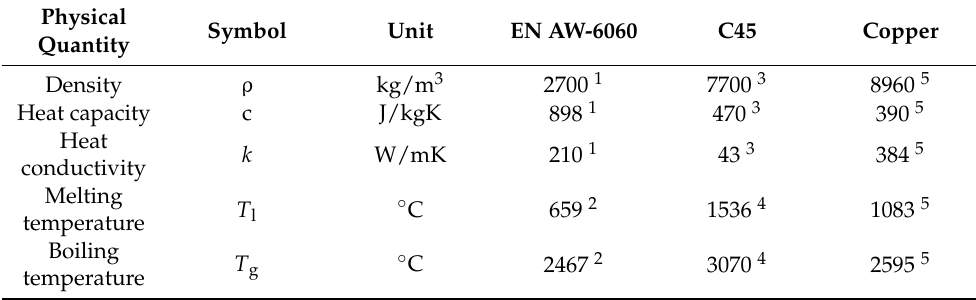
Table 4. Selected properties of the aluminum and steel alloy and copper.